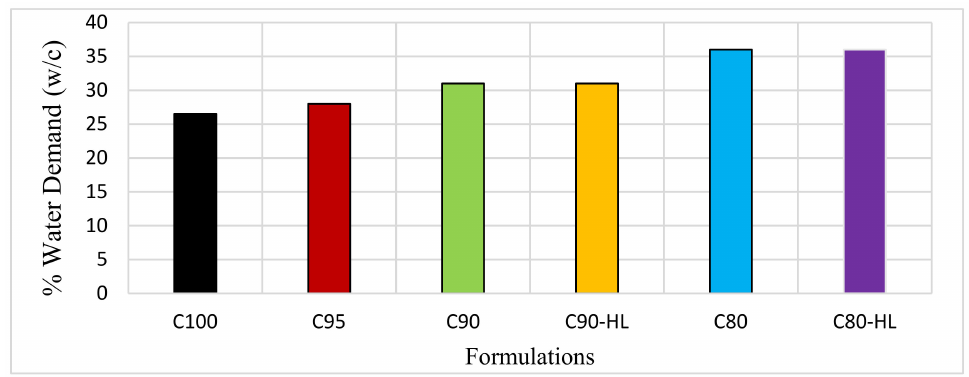
Figure 6. Effect of waste burnt brick powder on water demand of self-compacting paste formulations.